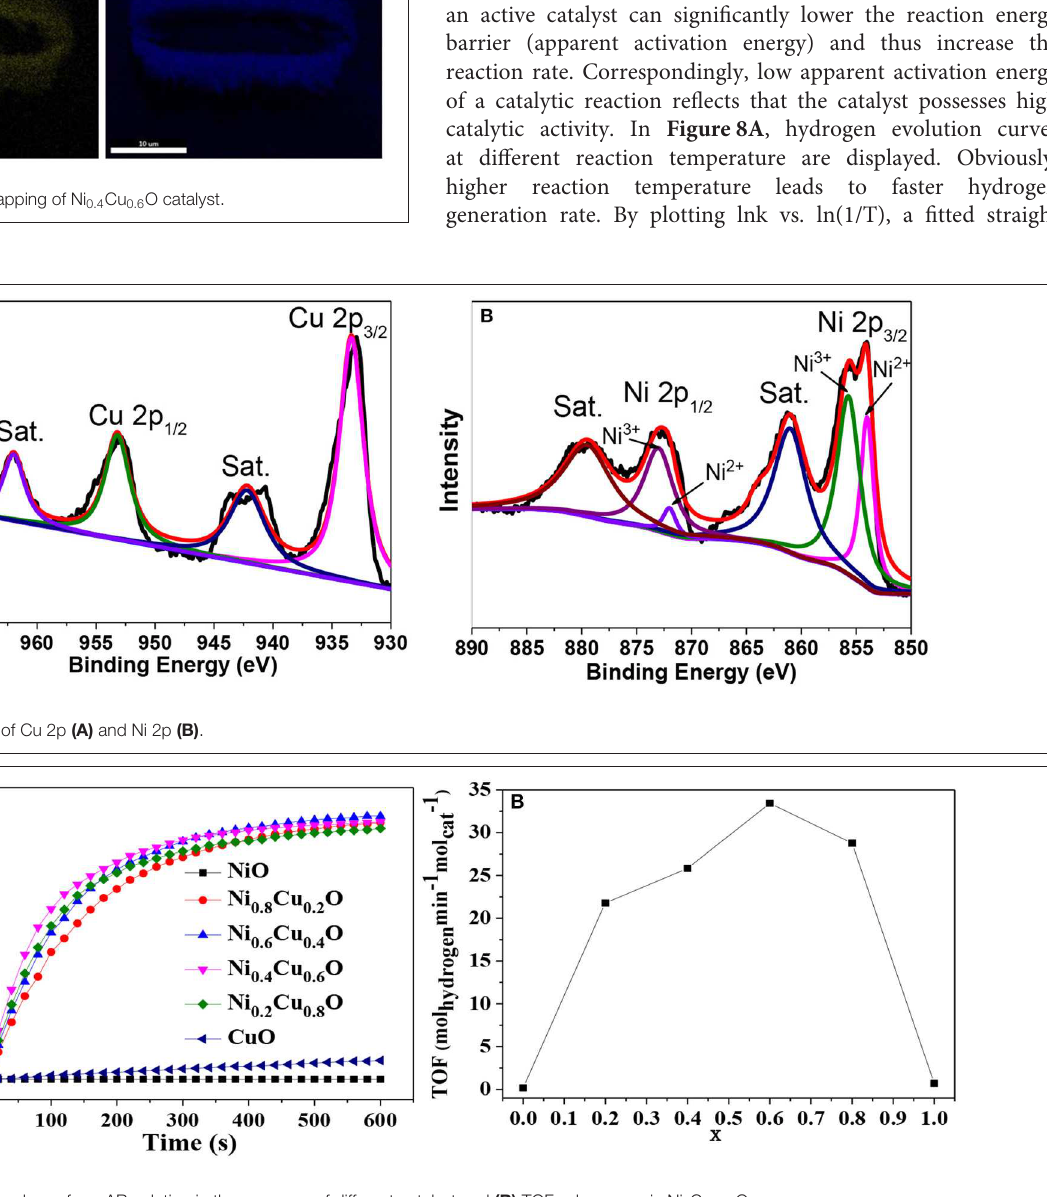
Frontiers in Chemistry |